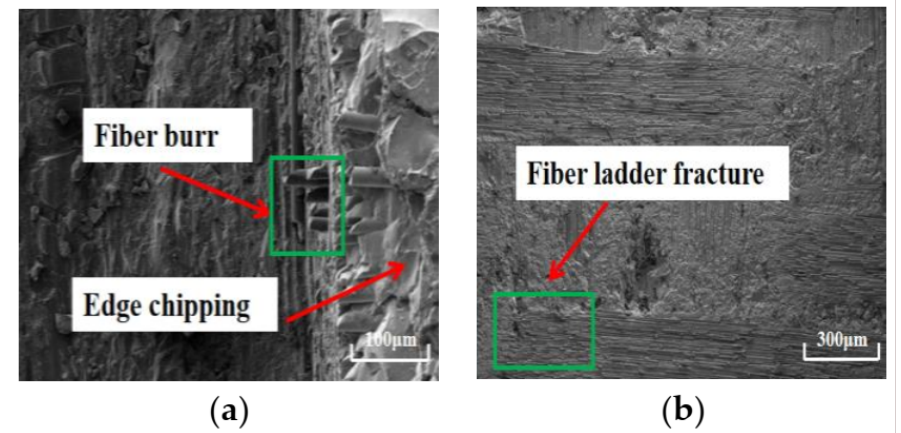
Figure 11. Morphology of the surface machined with CVD diamond tool in cryogenic machining: ( a ) sidewall ( × 300); ( b ) bottom ( ×